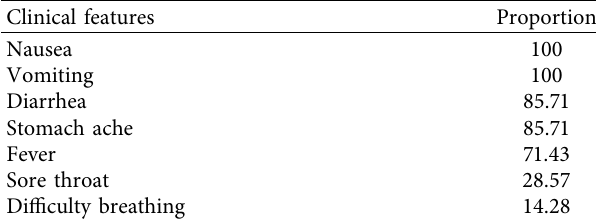
Table 1: Clinical features of the patients. Clinical